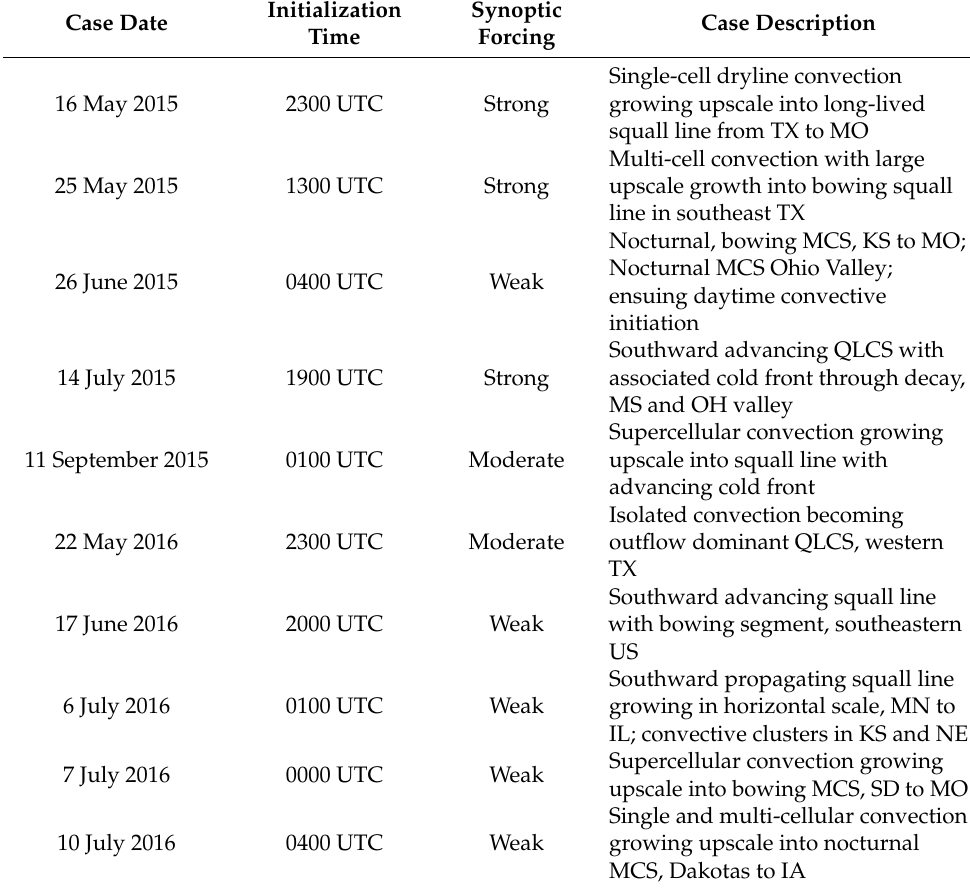
Table 4. Ten retrospective case studies from 2015 to 2016 and their storm morphology description. State abbreviations in this table are as follows: TX is Texas, MO is Missouri, KS is Kansas, MS is Mississippi, OH is Ohio, MN is Minnesota, NE is Nebraska, IL is Illinois, SD is South Dakota, IA is Iowa, and Dakotas refers to North and South